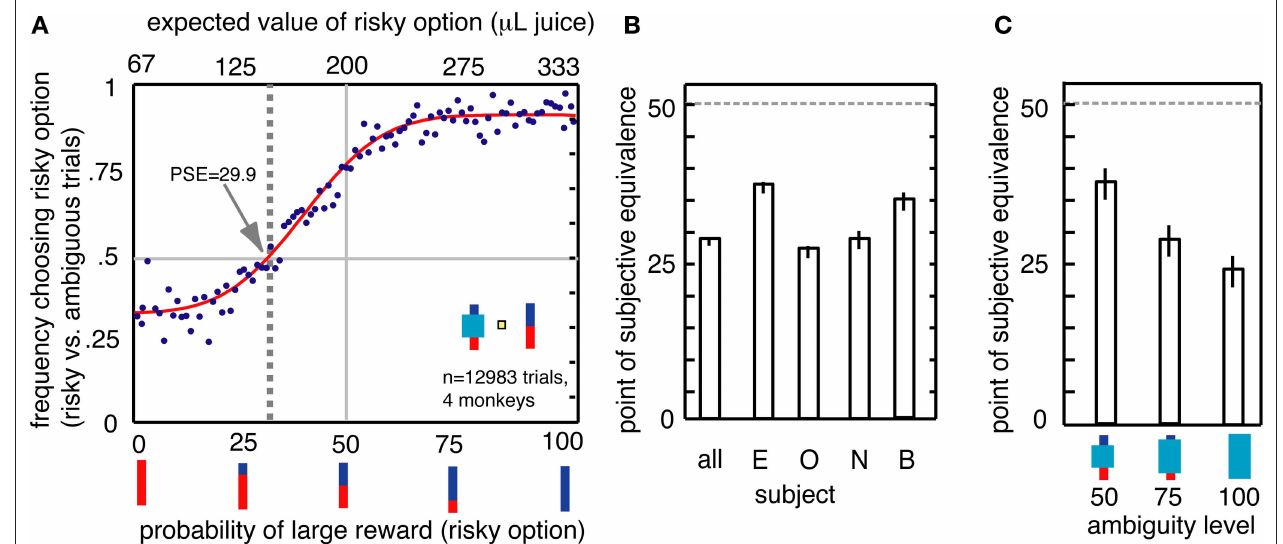
were indifferent to the two options. The PSE is smaller than 50, indicating that monkeys were ambiguity-averse. (B) Individually, all four monkeys showed ambiguity aversion (PSE significantly less than 50). (C) Ambiguity aversion varied parametrically with degree of ambiguity. Greatest aversion was observed for high uncertainty